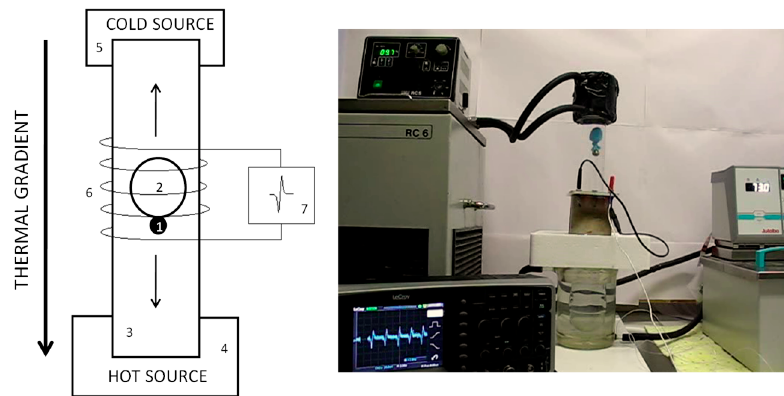
Figure 7. Scheme ( left ) and picture ( right ) of the experimental set-up (1: magnetic marble, 2: elastic bag, 3: water-filled column, 4: hot source, 5: cold source, 6: solenoid, 7: oscilloscope). A video of the setup in action is provided in the supplementary materials.